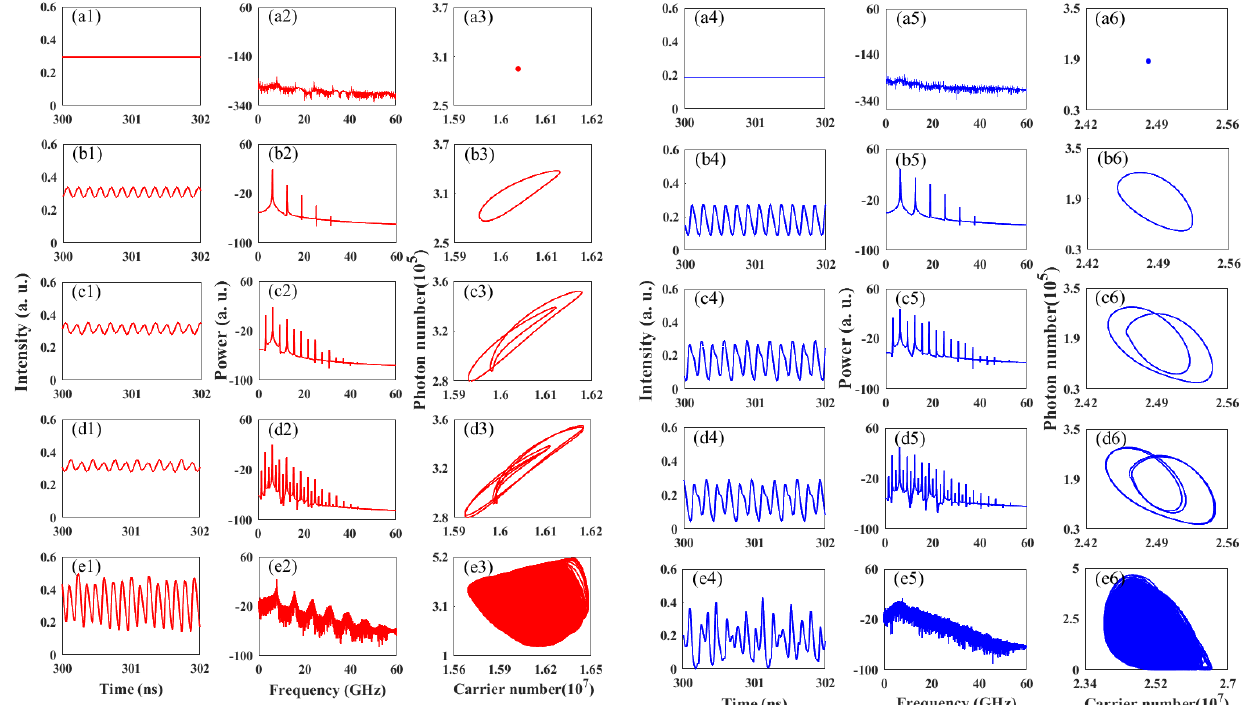
Figure 3. Time series, power spectra, and phase portraits output from GS lasing (red) and ES lasing (blue) in a TSQDL biased at 120 mA under optical feedback with τ = 100 ps and k = 0.03 ( a ), 0.07 ( b ), 0.092 ( c ), 0.097 ( d ), and 0.154 ( e ), respec- tively.